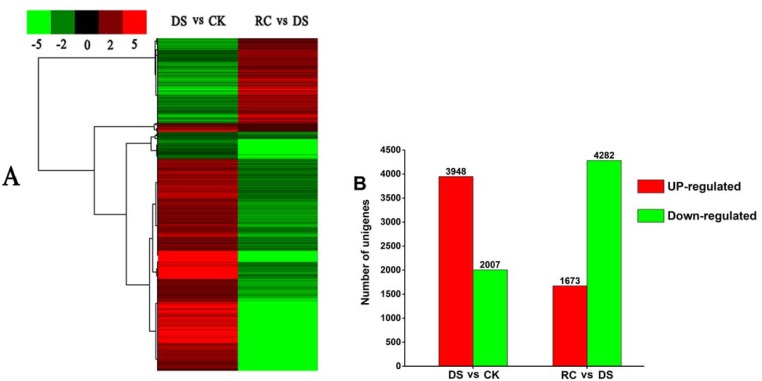
Changes in transcript levels of differentially expressed genes (DEGs) in tea plant during and after drought stress.(A) Heat-maps of all DEGs. Columns and rows in heat maps represent samples and DEGs, respectively. (B) Number of up- and down-regulated DEGs under dehydration and rehydration (FDR<10−3, P-value<10−5, |log2ratio|≥1).